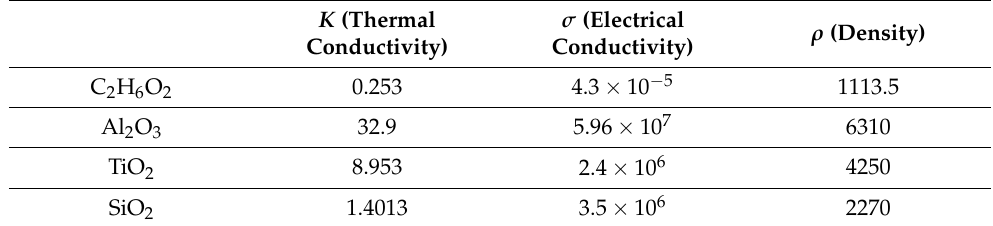
Table 1. Thermal properties [34] of density, electrical conductivity, and thermal conductivity. σ (Electrical ρ (Density) Conductivity) 𝑲 (Thermal C 2 H 6 O Conductivity)